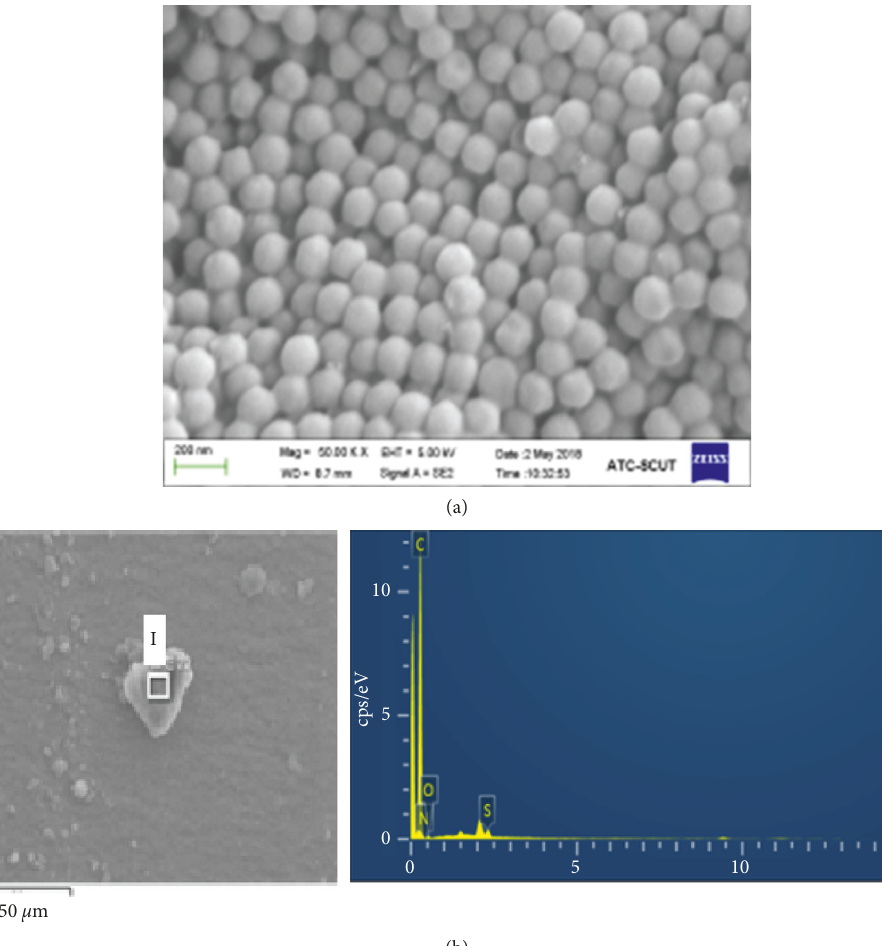
Figure 10: (a) SEM diagram of SPS nanoparticles before immobilization. (b) EDS spectrogram of SPS nanoparticles before